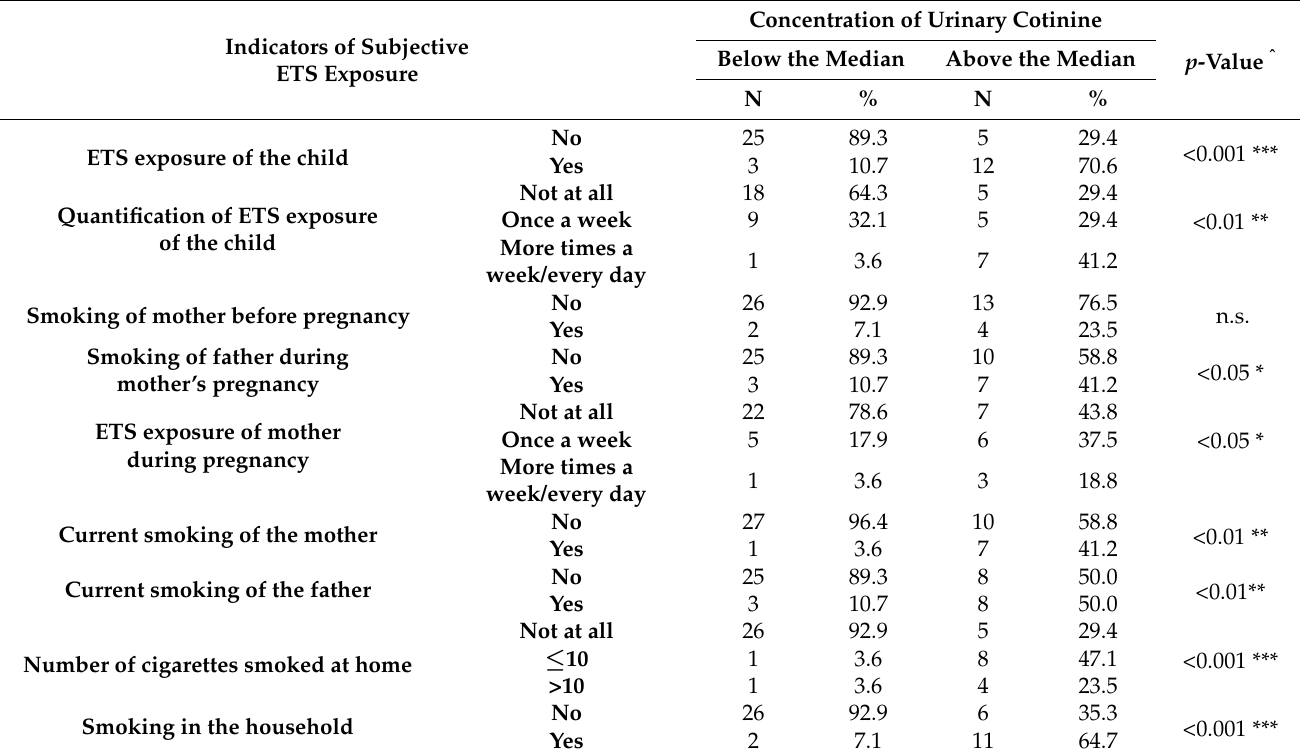
Table 6. Subjective ETS exposure comparing to the median concentration of urinary cotinine ( n = 45). Concentration of Urinary Indicators of Subjective ETS Exposure